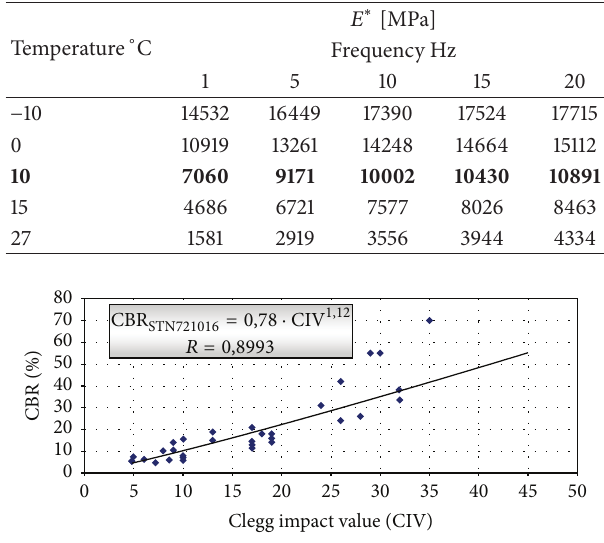
Table 2: Complex modulus of AC11 measured at different frequen- cies.